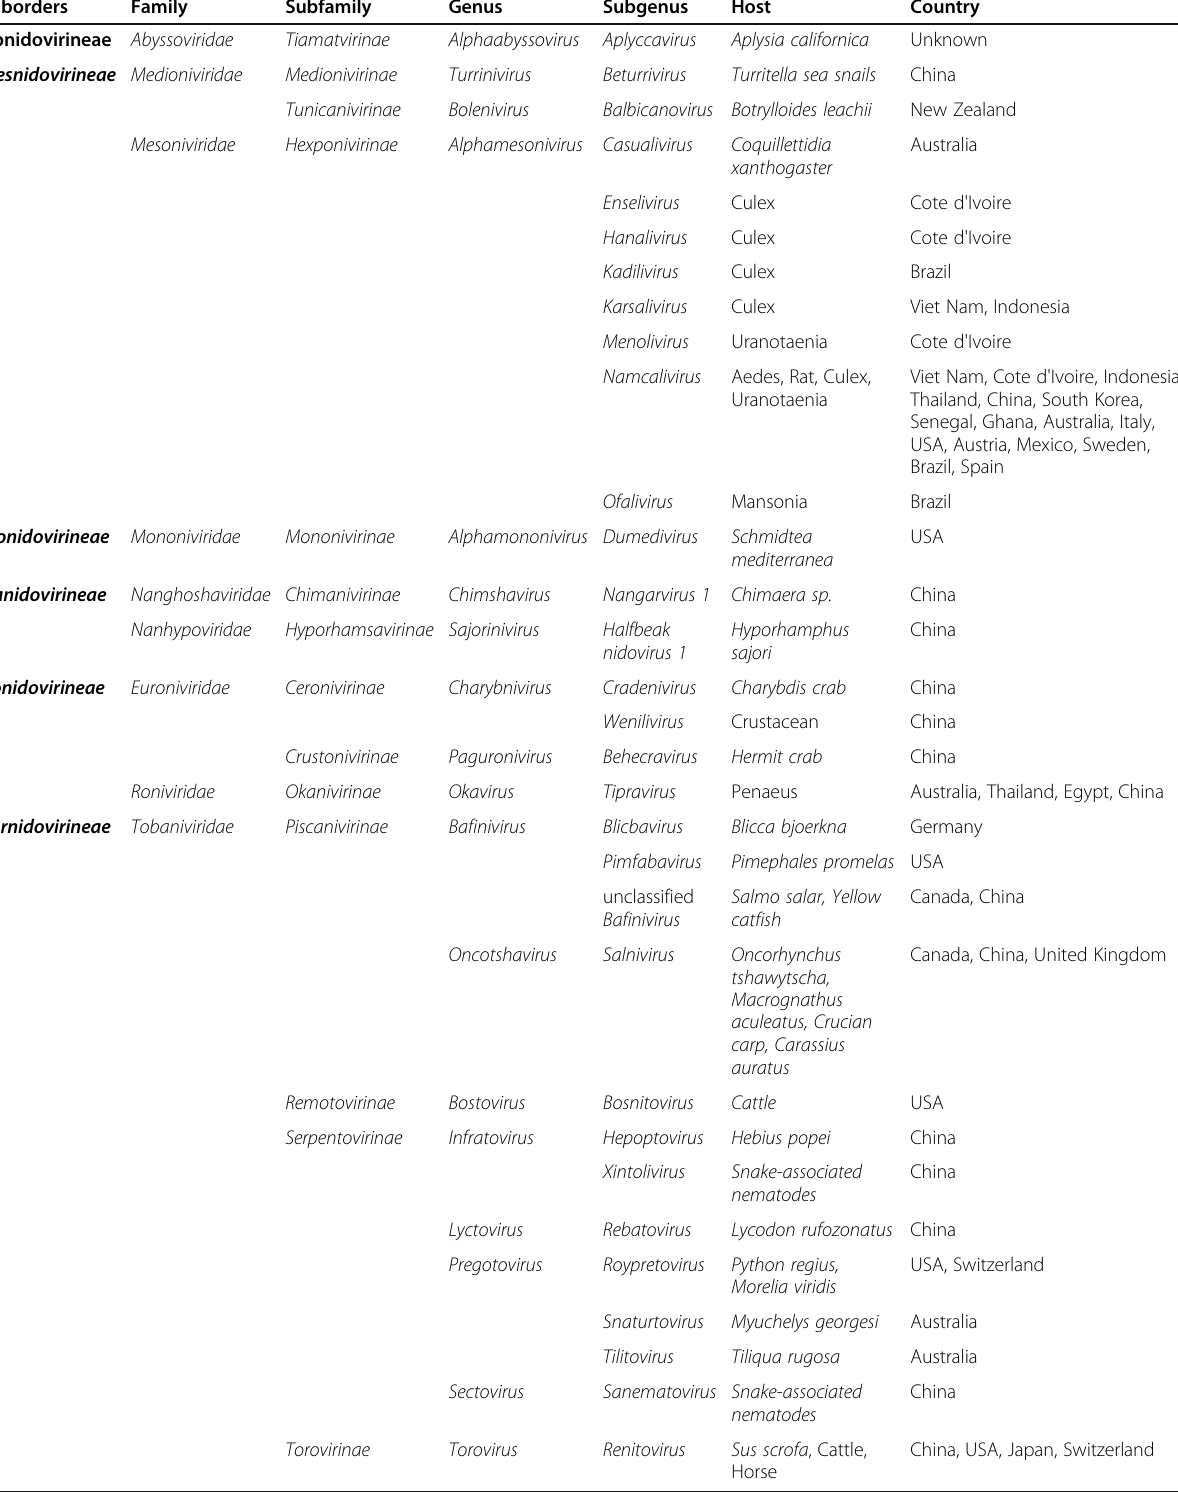
Table 3 Hosts and sampled countries of Ab- , Mes- , Mo- , Na- , Ro- and Tor-Nidovirineae viruses